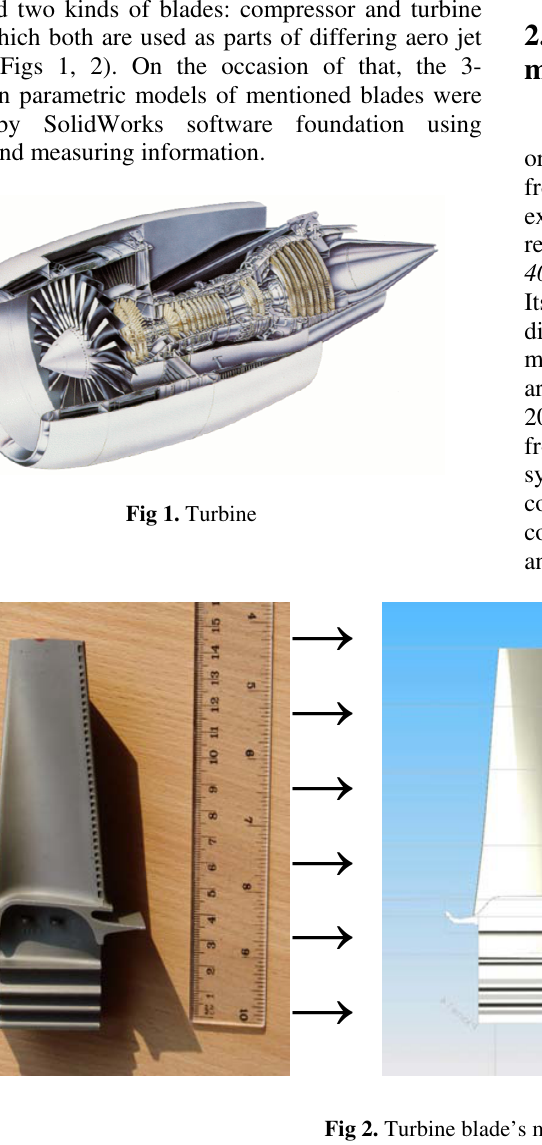
Fig 2. Turbine blade’s